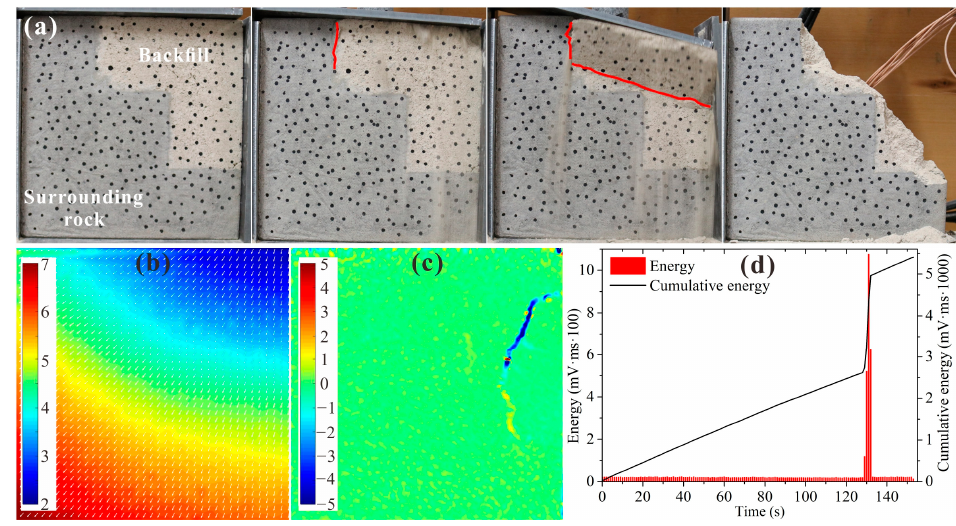
Figure 13. Experimental results for type E. ( a ) Damage and failure processes; ( b ) displacement field; ( c ) strain field; ( d ) acoustic emission energy.